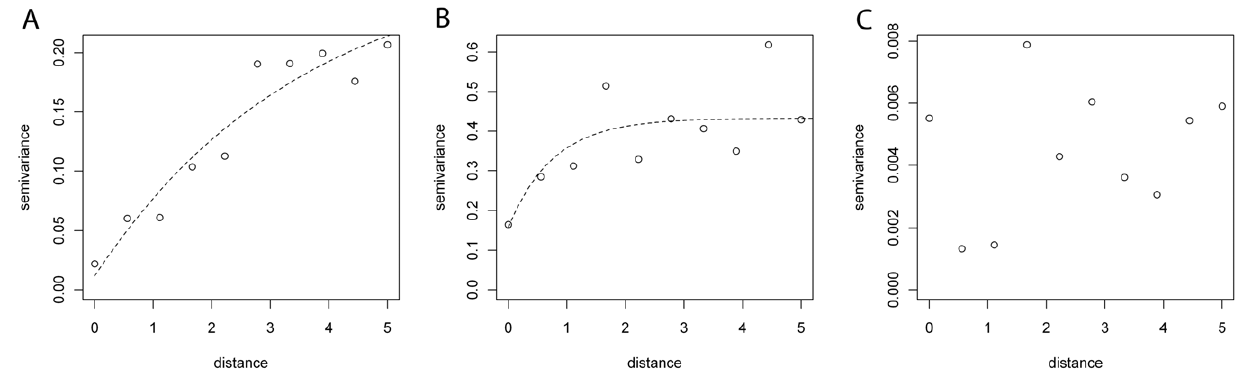
Figure 2. Semivariograms related to risk mapping models for active trachoma in children aged 1–9 years, Southern Sudan, 2001– 2009. A) raw data and Person’s residuals of: B) model 1; and C) model 2. Models 1 and 2 refer to the models presented in Table 1.